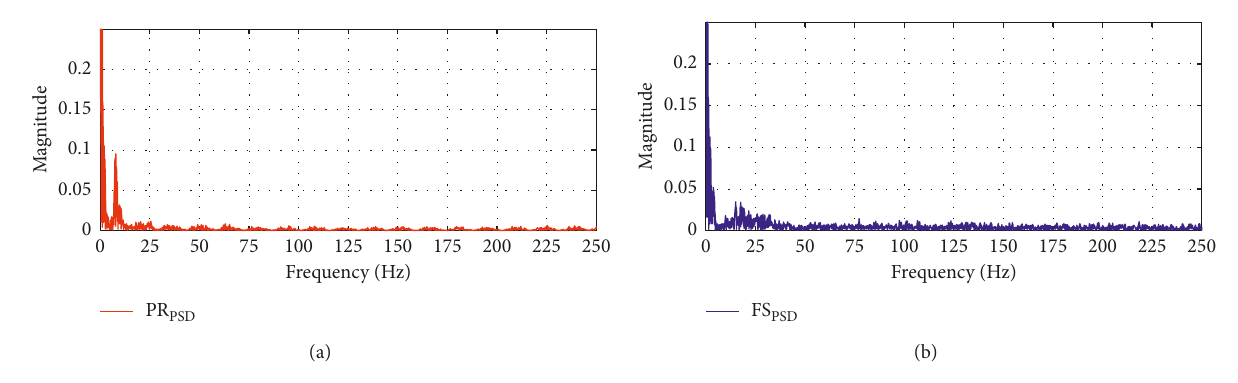
Figure 7: Control input voltage.